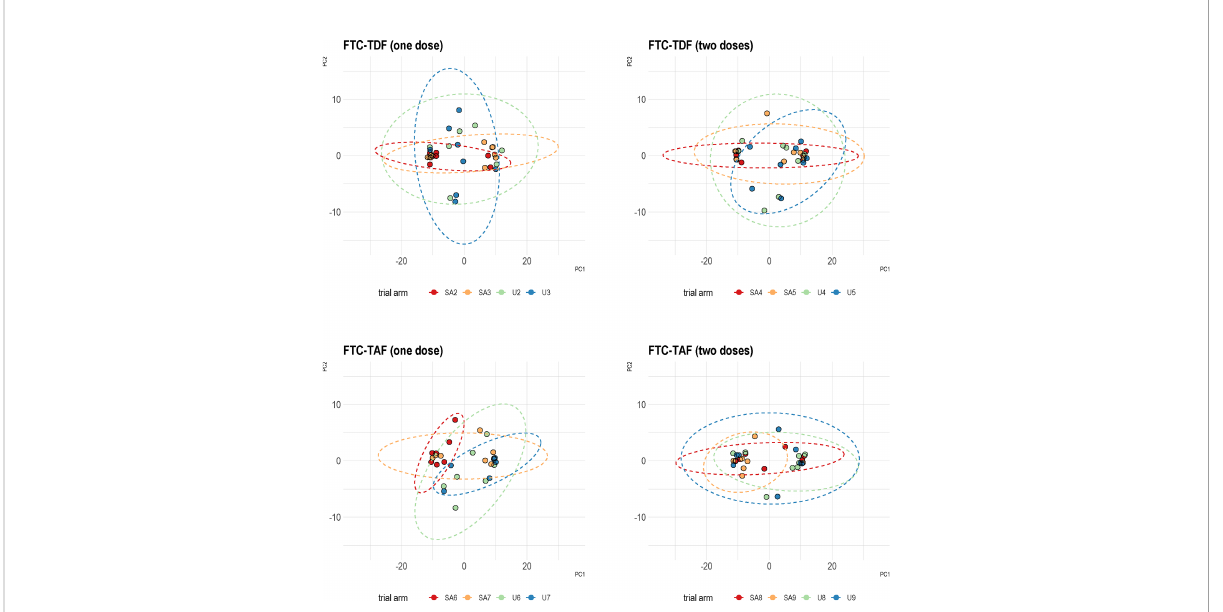
FIGURE 5 Principal component analysis of Uganda and South Africa trial arms combined together. Specimens from the two trial sites were analyzed based on the type of PrEP and number of administered doses. PCA was then performed using protein coding transcripts (N=15378). The overlap between the trial arms from two countries is shown by corresponding ellipses. A color coding in the fi gure denotes the different trial